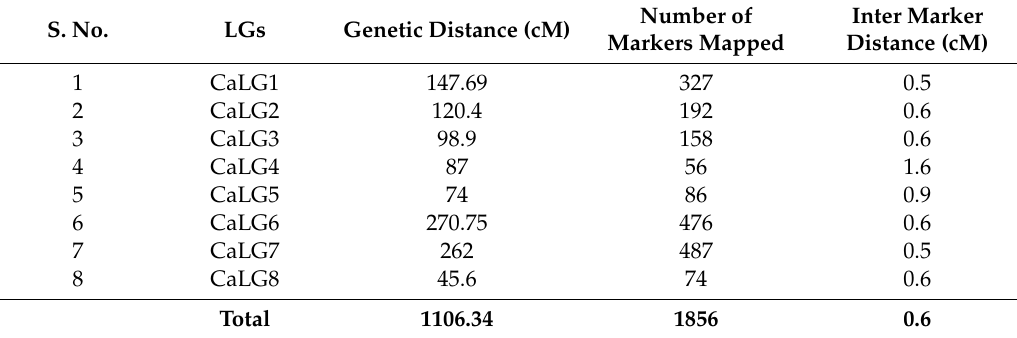
Table 3. Distribution of markers on the eight linkage groups (LGs) of the chickpea genetic map for the ICCV 10 × DCP 92-3 RIL